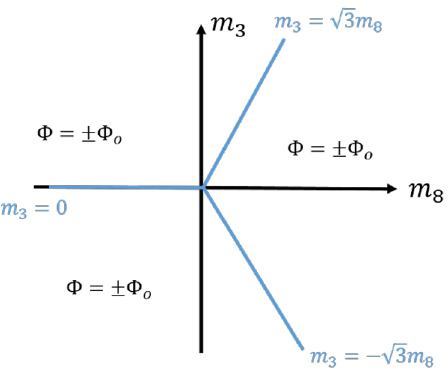
Figure 3 . The phase diagram of the 3 d N = 1 WZ model. At generic points we (cid:12)nd two gapped vacua at low energies, while along the blue rays we (cid:12)nd a CP 1 model. (cid:8) 0 is given in appendix A.1, and a simple analysis shows that vacuum crossing occurs as we go around the